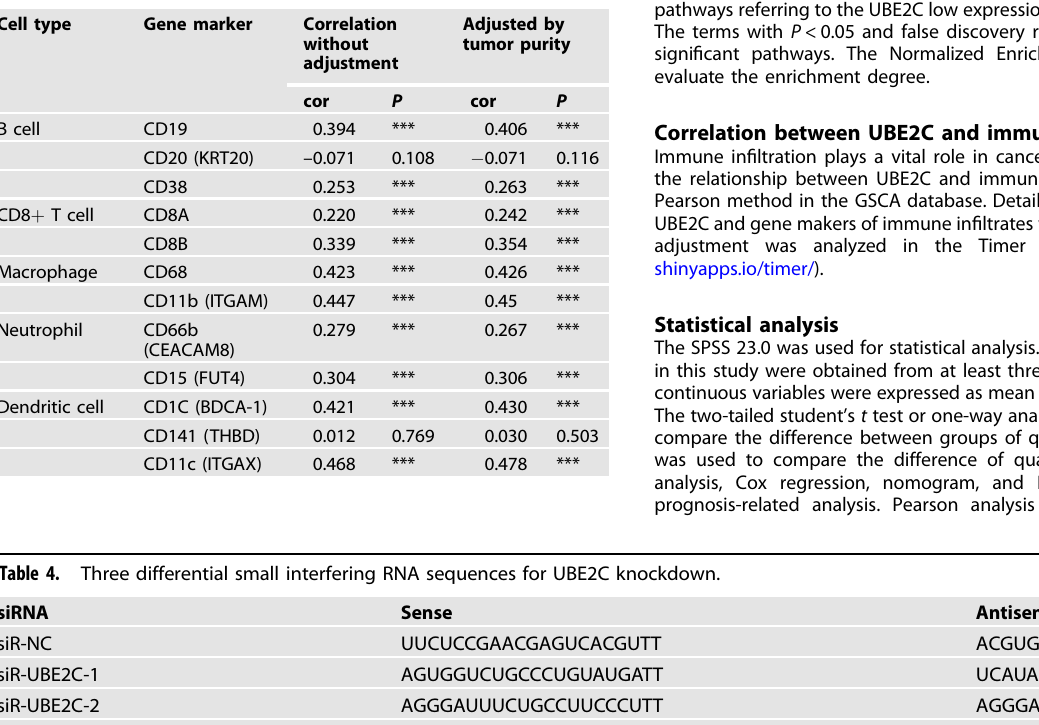
Table 3. Correlation analysis between UBE2C and markers of immune cells in TIMER.